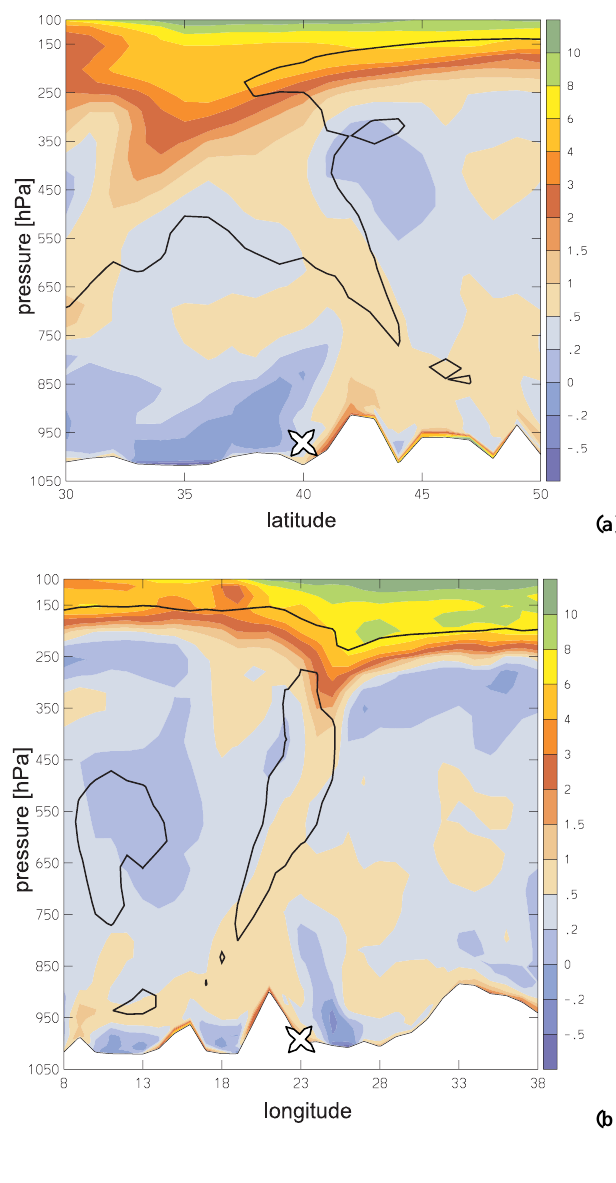
Fig. 6. (a) Vertical cross section of potential vorticity ( PV u) over Thessaloniki for 29 November 2000 at 18:00 UT, along the south- north direction (latitudes form 30 ◦ to 50 ◦ N). Solid bold lines show regions with low humidity ( < 10%) (Thessaloniki is marked by X). (b) Vertical cross section of potential vorticity ( PV u) over Thes- saloniki for 29 November 2000 at 18:00 UT, along the west-east direction (longitudes form 8 ◦ to 38 ◦ E) (Thessaloniki is marked by